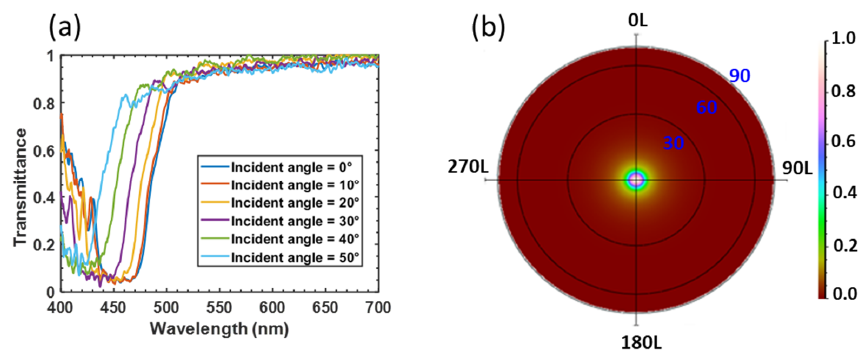
Figure 2. ( a ) Measured reflection spectrum of planar texture (P-CLC) film at different incident angles. ( b ) Measured angular transmission profile of focal conic texture (FC-CLC) film at normal incidence.